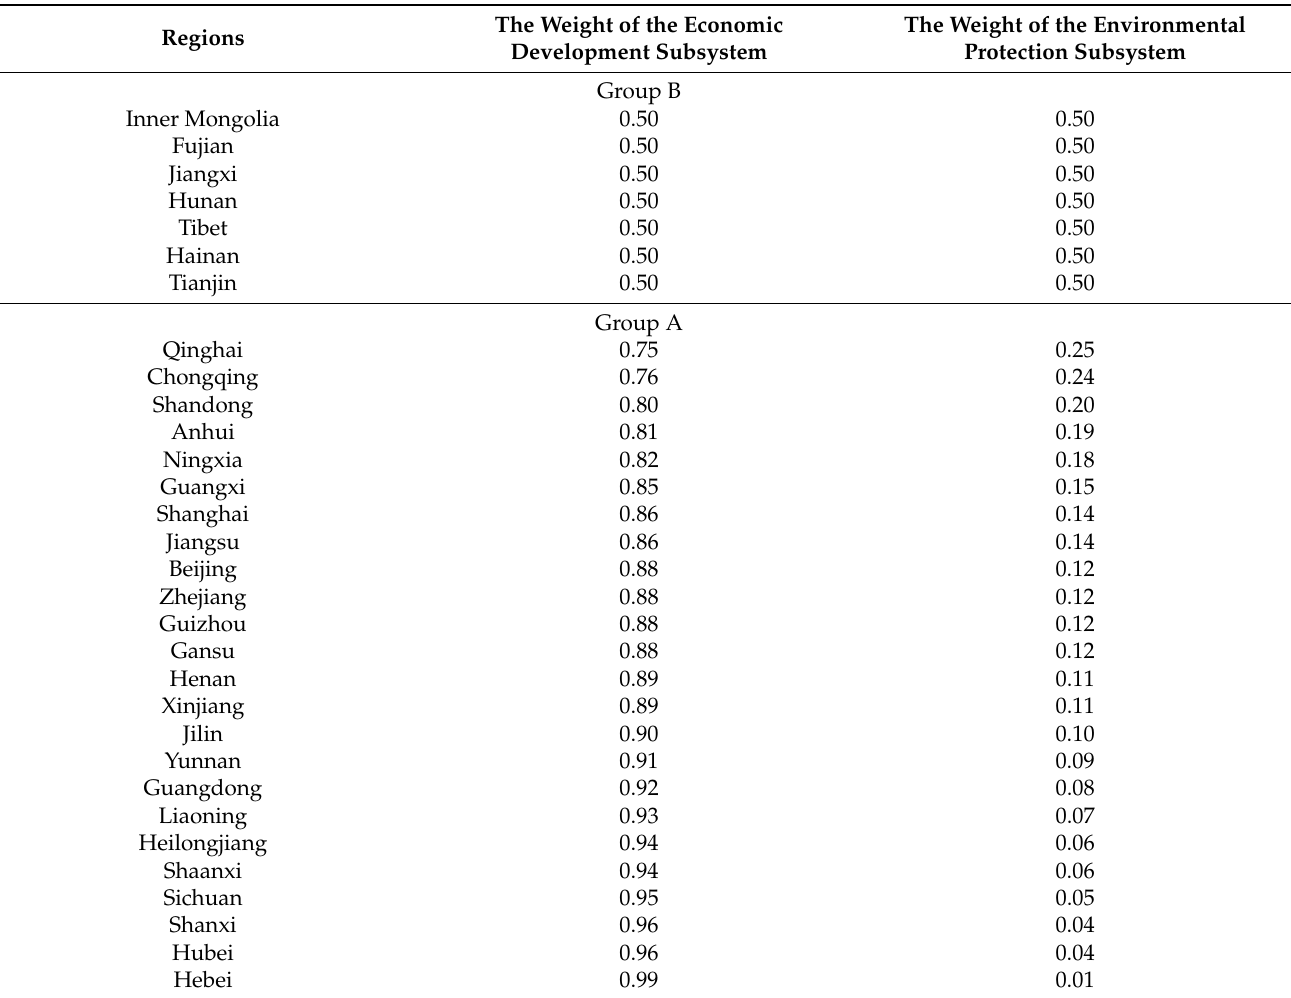
Table 2. The weights of the production subsystem and environment protection subsystem in each region.